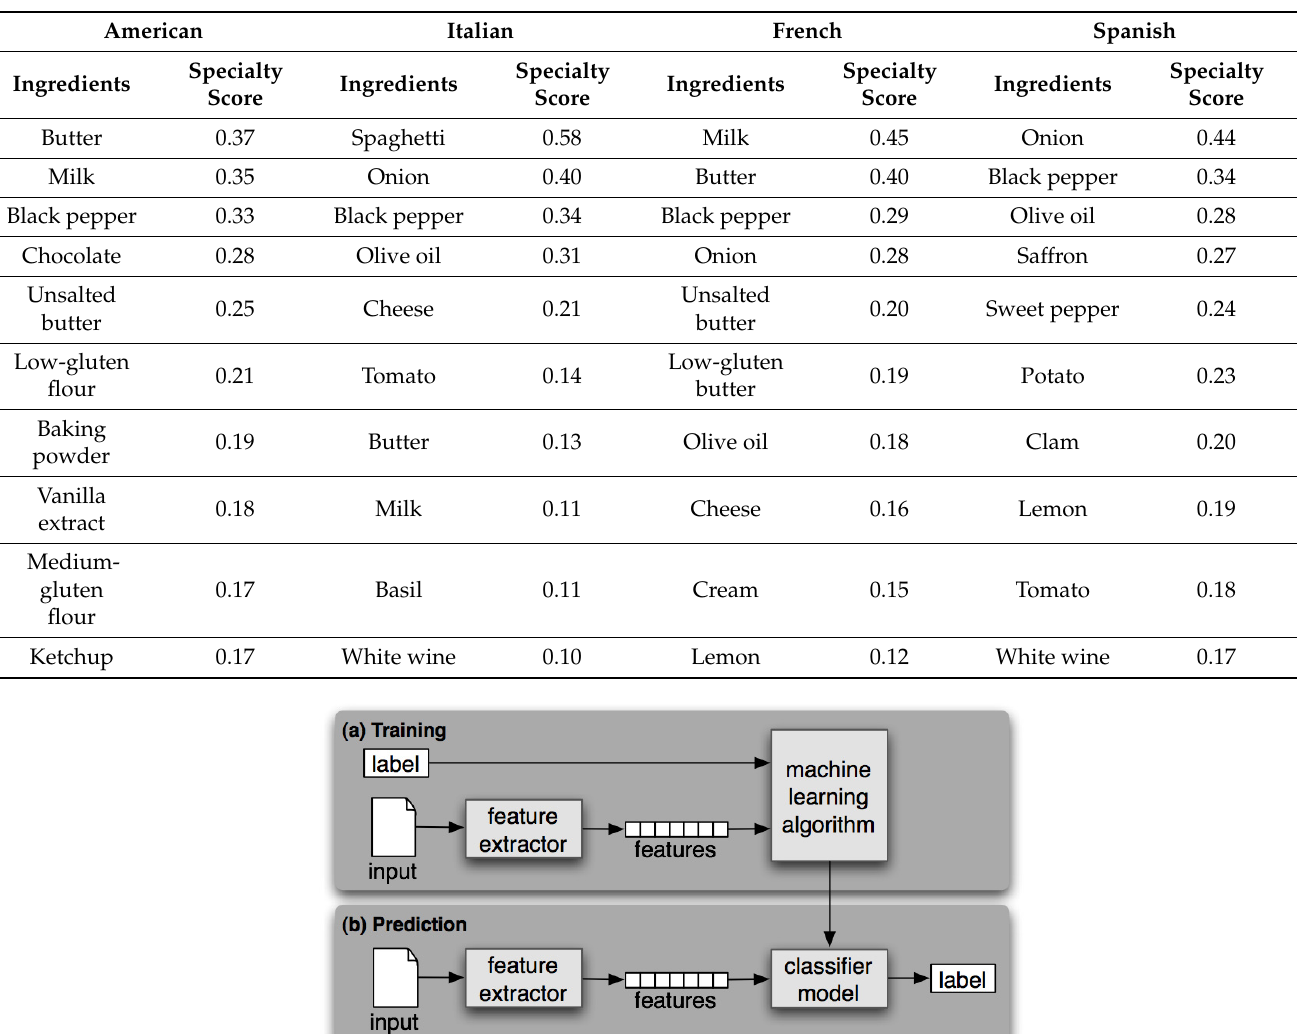
Table 3. American, Italian, French, and Spanish cuisines’ Specialty score of ingredients.